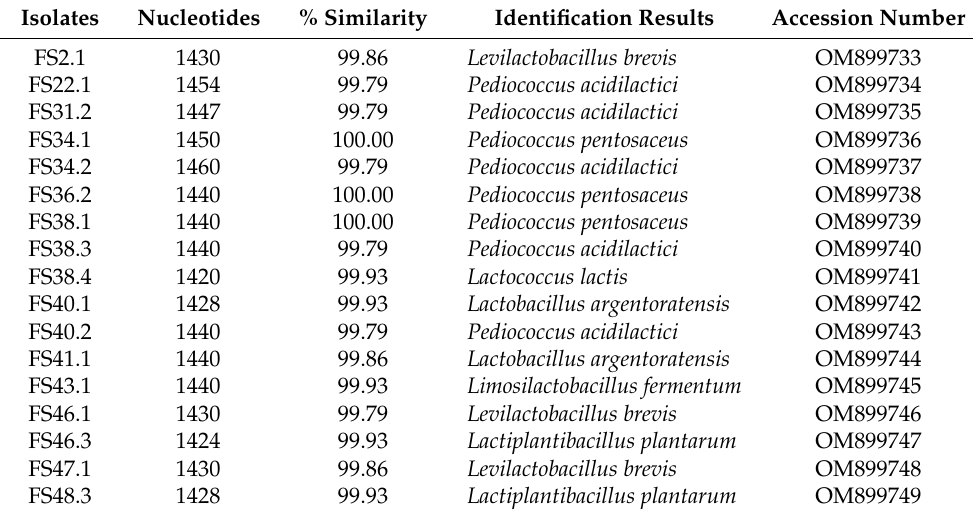
Table 2. Molecular identification of 16S rRNA gene sequences of XOSs-fermenting LAB. Isolates